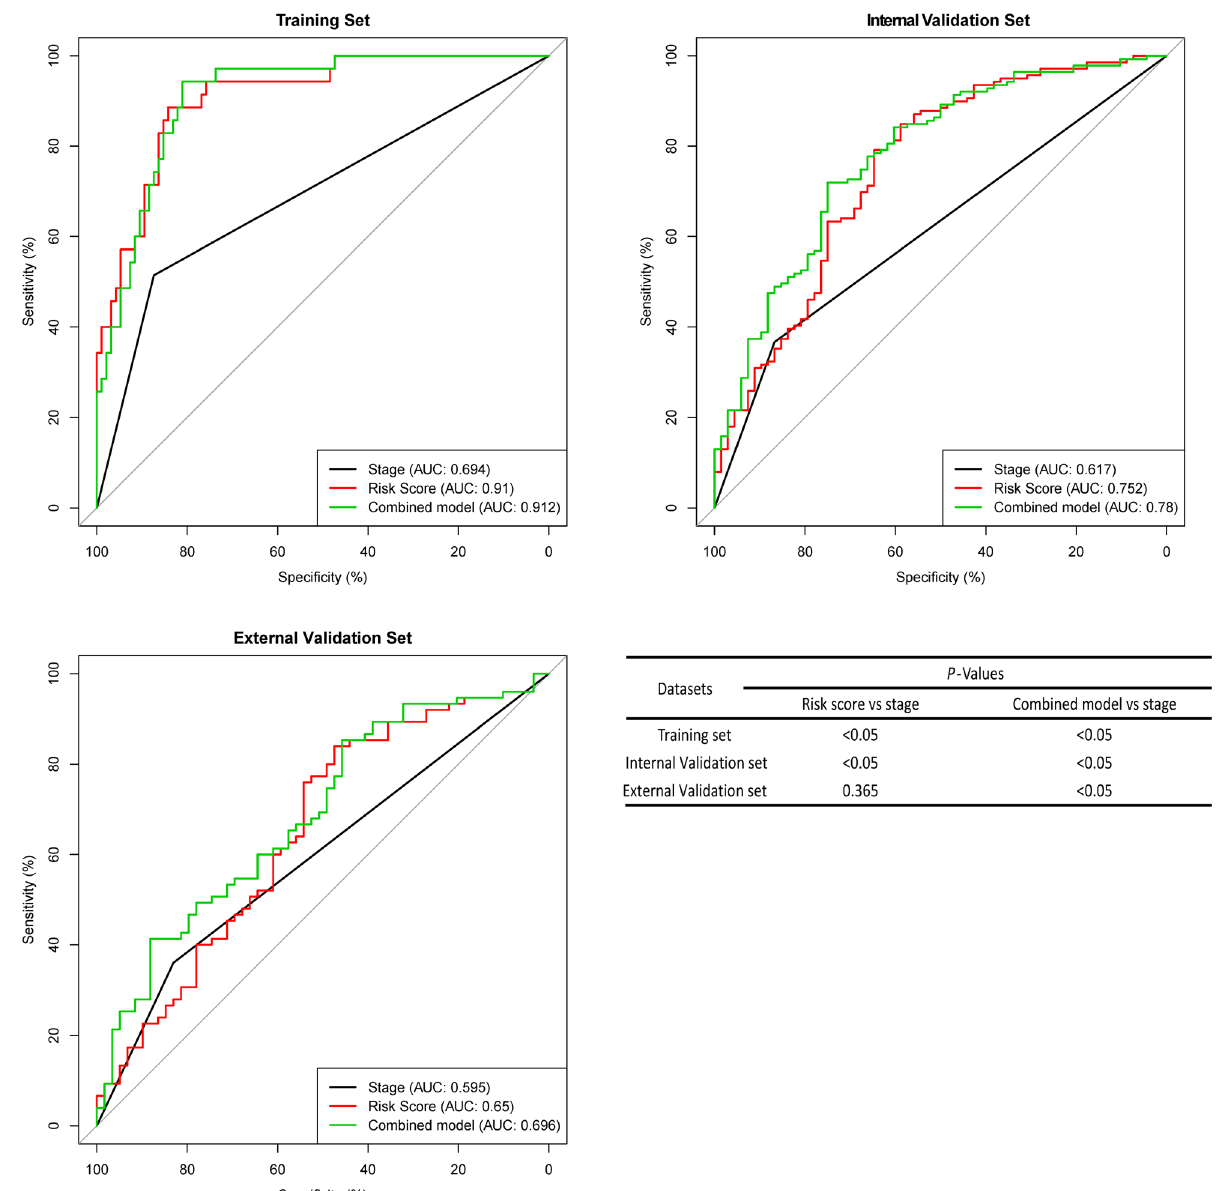
Figure 6. ROC curves of the combined model of the fifteen-mRNA signature and stage, the fifteen-mRNA signature and stage alone for each set. The AUC of the fifteen-mRNA signature was higher than that of stage alone in the training ( P < 0.05) and internal validation sets ( P < 0.05). The combined model’s (fifteen-mRNA signature and tumour stage) AUC was higher than that of stage alone in each set ( P < 0.05). Abbreviation: AUC, area under the curve.